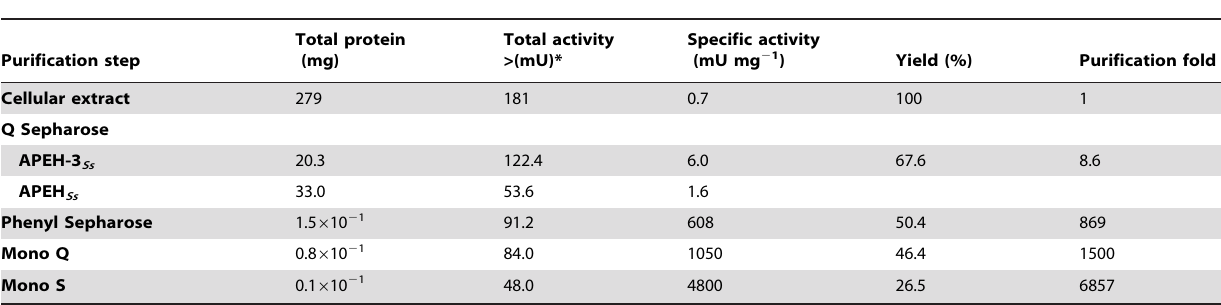
Table 1. Purification procedure of APEH-3 Ss enzyme from S. solfataricus